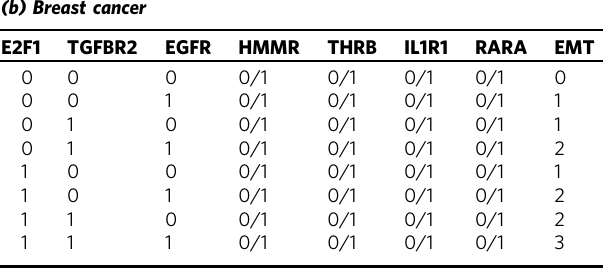
Active state of the molecule is represented by ‘ 1 ’ and the inactive state as ‘ 0 ’ . The phenotype output(EMT)cantakefourordinallevelsrangingfrom ‘ 0 ’ (non- invasive)to ‘ 3 ’ (highlyinvasive). Table (a) is the summary of 64 in silico simulations of bladder cancer. Each row represents the resultofeightsimulationswhereforthegivenBooleanstateofE2F1,TGFBR1,andFGFR1,alleight combinations of EGFR, CXCR1, and RARA results in the same phenotypical output. Table (b) is the summary of 128 in silico simulations of breast cancer. Each row represents the result of 16simulations where for thegivenBooleanstate of E2F1, TGFBR2, andEGFR,all16 combinations of HMMR, THRB, IL1R1, and RARA results in the same phenotypical